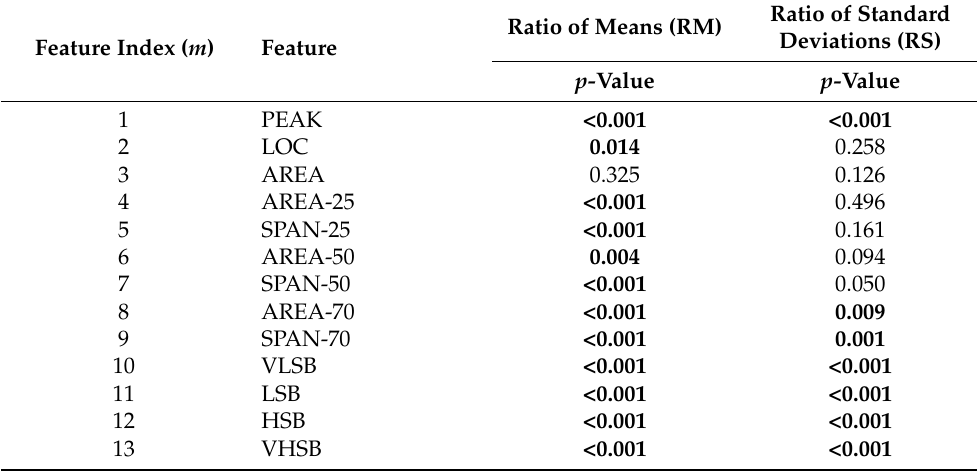
Table 7. Hypopnea hypothesis testing (bold for p -value < 0.05, N = 801).